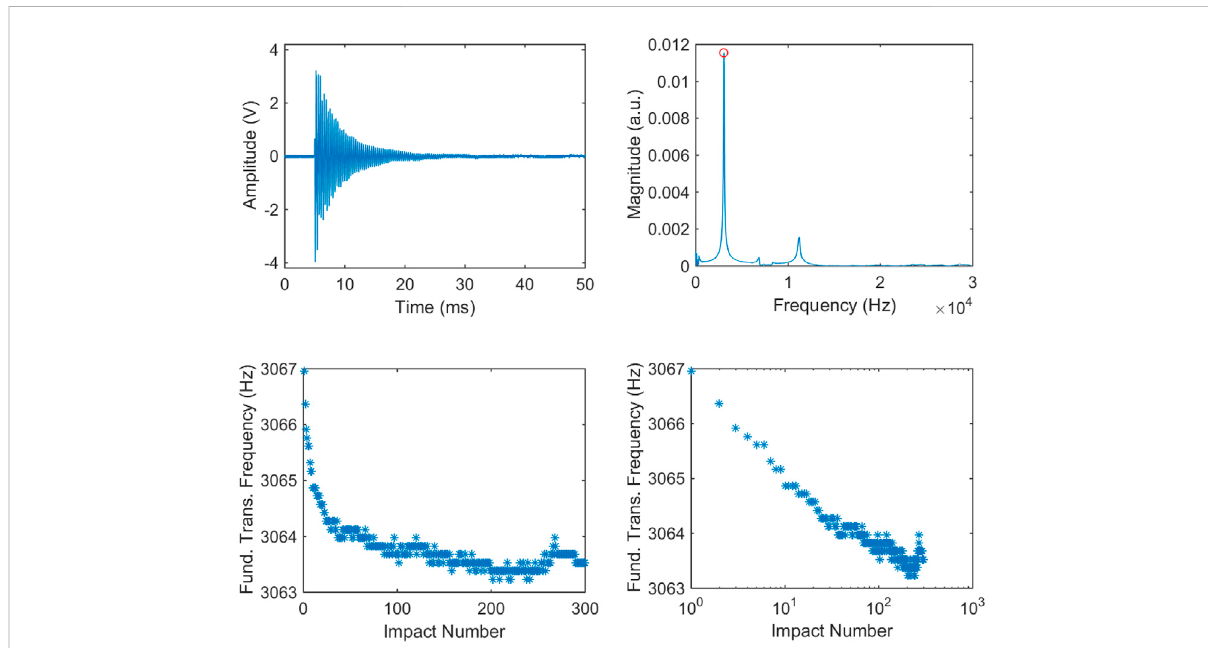
FIGURE 5 Singleimpactvibrationtimesignal(topleft)anddiscretefrequencyspectrum(topright)withthefrequencyofthefundamentaltransversemode identi fi ed by a red circle. Linear (bottom left) and semi-log (bottom right) plots of fundamental transverse frequency recorded during sequential impact testing set of dry cement paste (0.5 w/c) in uncontrolled laboratory